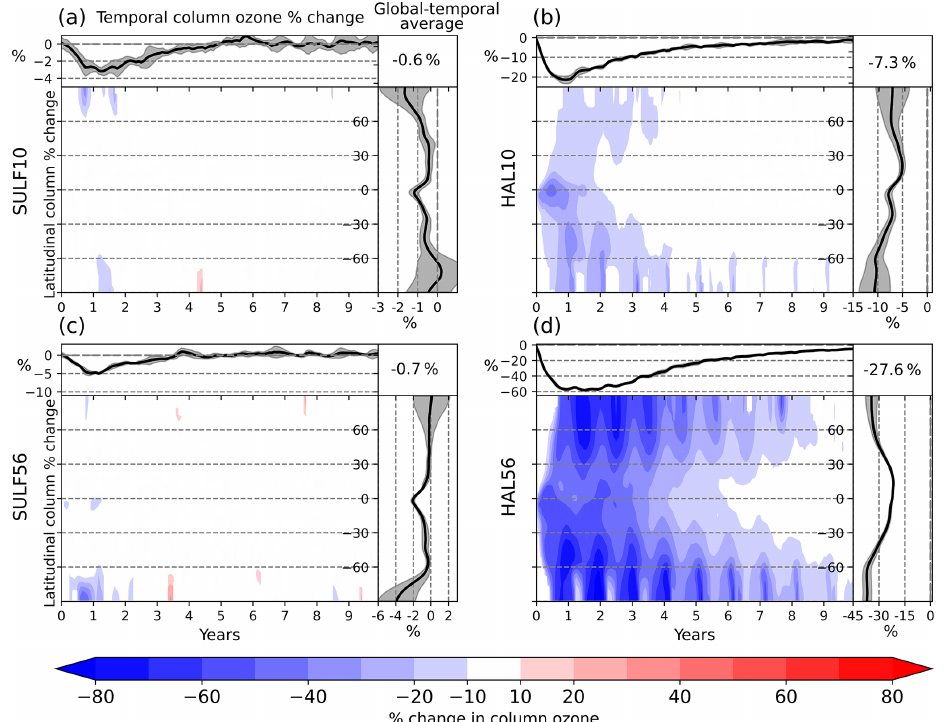
Figure 5. Ozone percentage difference in (a) SULF10, (b) HAL10, (c) SULF56, and (d) HAL56. Global-mean total column ozone anomalies are traced as a function of time at the top of each panel. Temporal-mean ozone anomalies are traced on the right; note the different scales. Global-temporal mean anomalies are enumerated in the top right. Red colours indicate column ozone enhancement, and blue colours indicate column ozone depletion. Grey shaded areas represent the ensemble